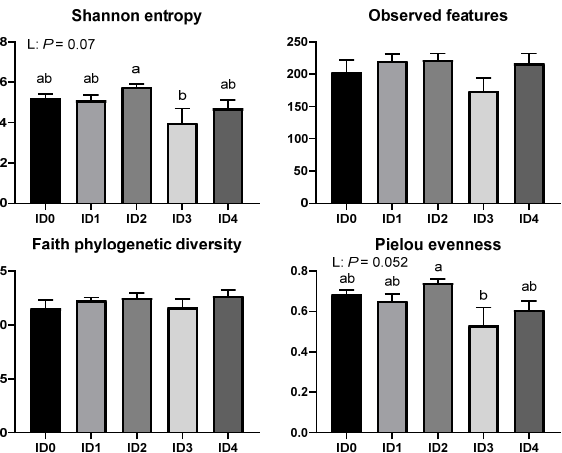
Figure 1. Effects of different infection doses of Eimeria tenella on alpha diversity parameters of the cecal microbial communities in broilers 6 days post-infection. Alpha diversity parameters were measured in the ID0 (infection dose 0; Sham-challenged with phosphate-buffered saline); ID1 (infection dose 1; challenged with 6250 sporulated oocysts of Eimeria tenella ); ID2 (infection dose 2; challenged with 12,500 sporulated oocysts of E. tenella ); ID3 (infection dose 3; challenged with 25,000 sporulated oocysts of E. tenella ); ID4 (infection dose 4; challenged with 50,000 sporulated oocysts of E. tenella ) groups. Data were analyzed by using One-way ANOVA followed by the Tukey’s multiple comparison test and means with different letters (a and b) differ significantly ( p < 0.05). Orthogonal polynomial contrast analysis was used to assess linear (L) and quadratic (Q) effects of the infection doses, and p < 0.1 were presented. Distance to each infection dose in the unweighted unifrac beta diversity (dissimilar- ity among samples without considering abundance information) analysis is shown in Fig- ure 2. The ID0 group had significantly greater unweighted unifrac distance to the ID1 group compared to the ID1 group. The ID4 group had significantly greater weighted unifrac distance (dissimilarity among samples with considering abundance information) to the ID0 group compared to the ID0 group. The ID3 and ID4 groups had significantly greater weighted unifrac distance to the ID2 group compared to the ID2 group. In the visualized weighted unifrac beta diversity (Figure 3), different infection doses seemed clustered, and axis 1 score was comparatively high (>35%).